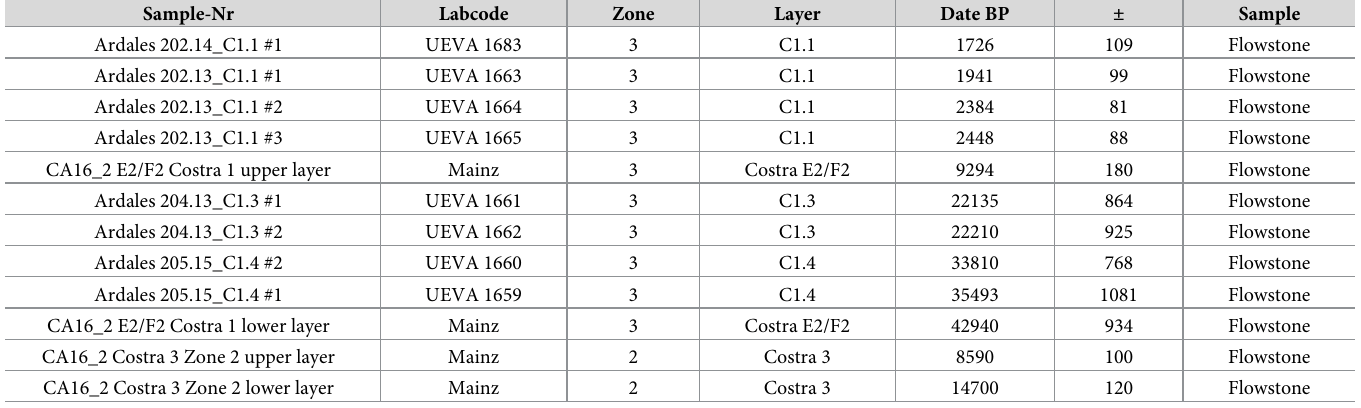
Table 2. U/Th Datings of flowstone layers in zone 2 and zone 3 of Cueva de